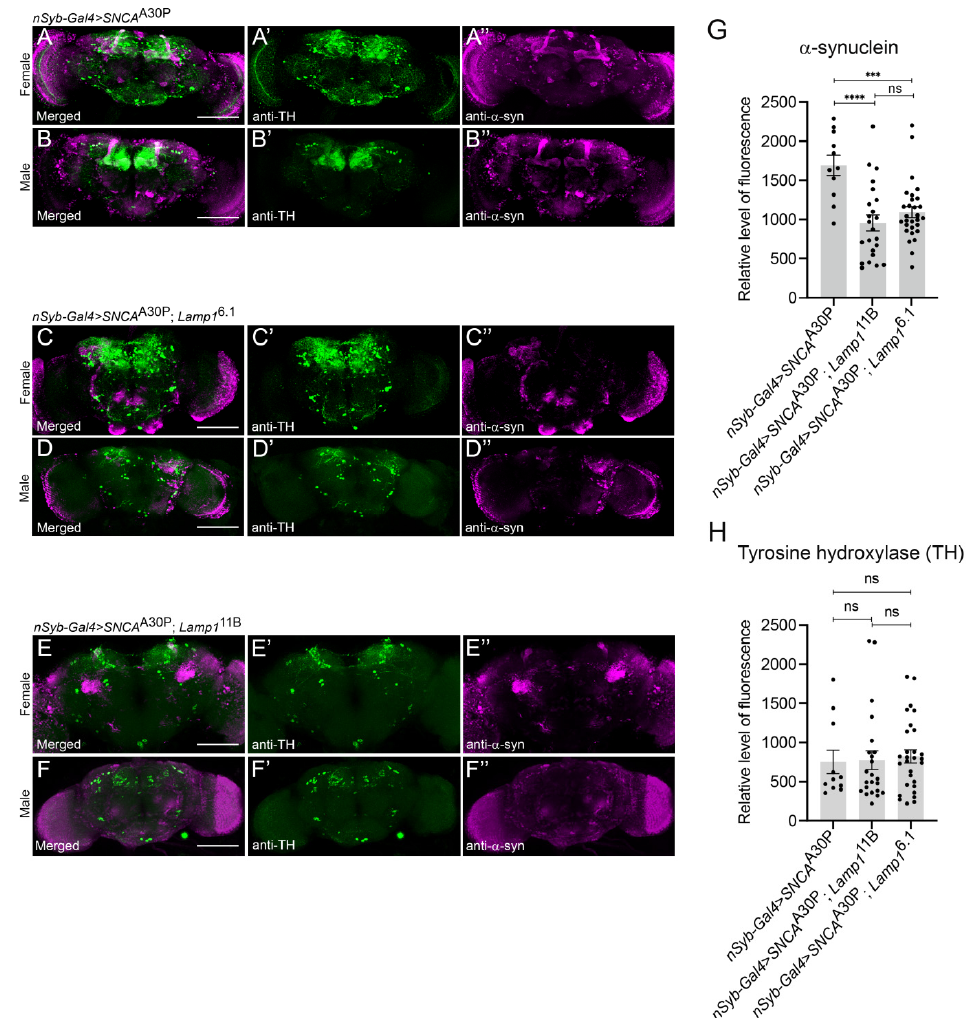
Figure 3. α -Synuclein accumulates less in Lamp1 -deficient Drosophila brains than in controls. ( A – F ) Representative confocal images of 5-day old brains from female and male w 1118 control WT flies ( A , B ), and Lamp1 6.1 ( C , D ) or Lamp1 11B ( E , F ) mutant flies, expressing α -synA30P ( SNCA A30P ) pan-neuronally with the driver nSyb-Gal4 . Maximum projection single channel images show TH (green) ( A’ – F’ ) and α -synuclein (magenta) ( A” – F” ), respectively. ( G , H ) Quantification of fluorescence intensity shows that the α -synuclein level is significantly lower in both Lamp1 6.1 and Lamp1 11B mutant brains compared to WT controls ( G ); nSyb-Gal4 >UAS-SNCA A30P ), while TH levels are unaffected at this age ( H ). Bar plots represent the fluorescence intensity levels measured in the whole central brain area excluding the optic lobes. Two-way ANOVA with Tukey’s post-hoc pairwise comparison test (**** p < 0.0001; *** p < 0.001, ns: not significant). Error bars represent SEM. Scale bars: 100 µm.